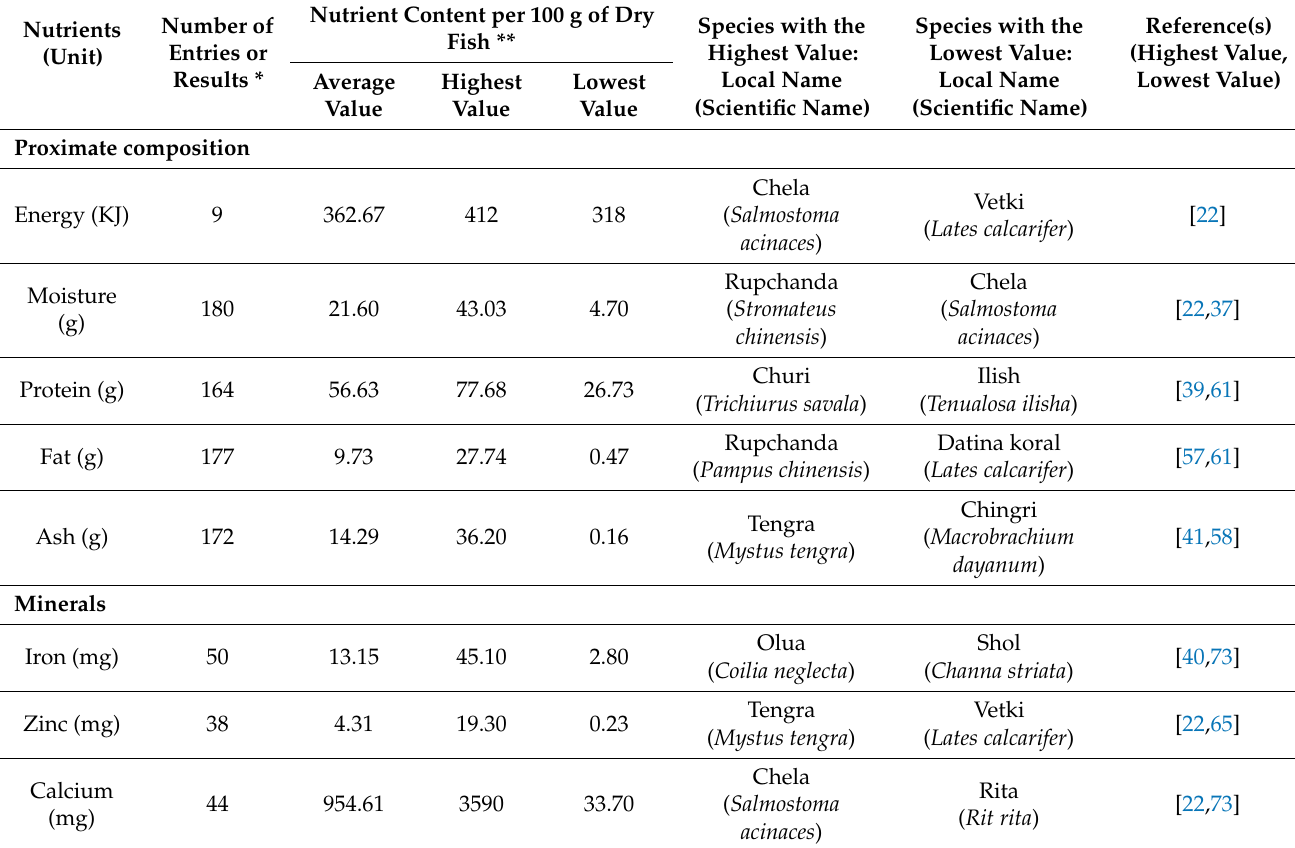
Table 1. Analyzed nutrients, average nutrient content, and name of dry fish species with the highest and the lowest nutrient